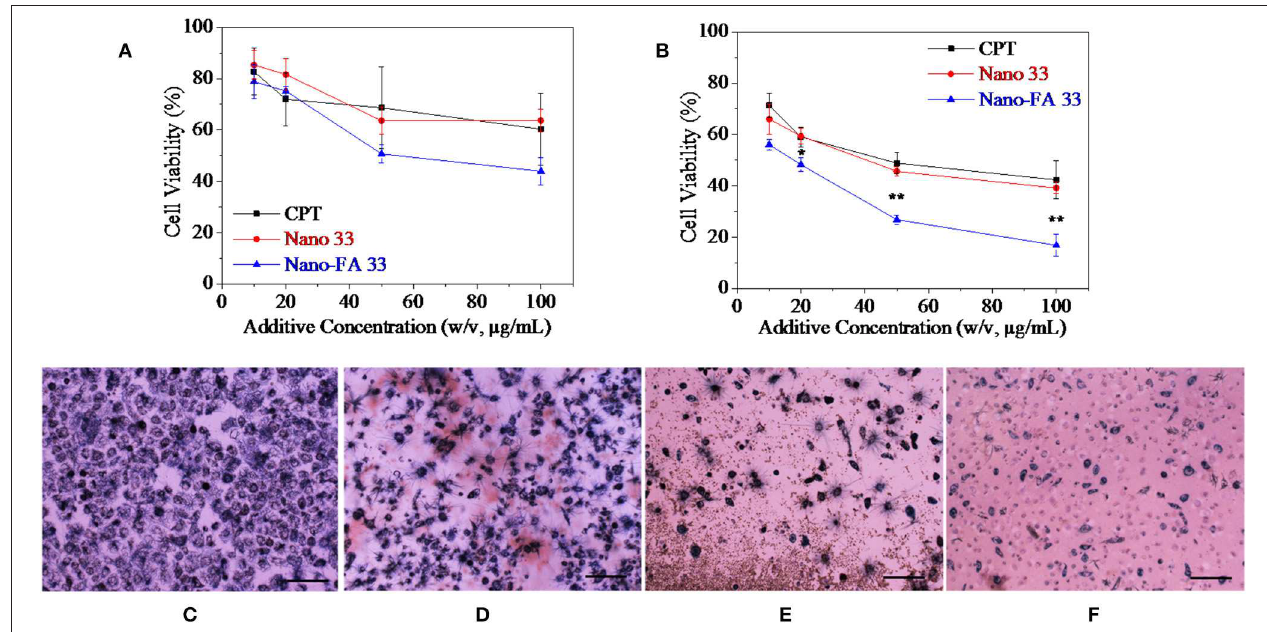
FIGURE 8 | Cell viability as a function of cocultured additive concentration after (A) 12h and (B) 24h. Optical microscopic images of cells on TCPs control (C) and with 100 µ g/ml (D) CPT, (E) Nano 33, and (F) Nano-FA 33 after cultured 24h. Cell seeding density is 2*10 4 /well. Cells were stained by MTT. The scale is 100 µ m.